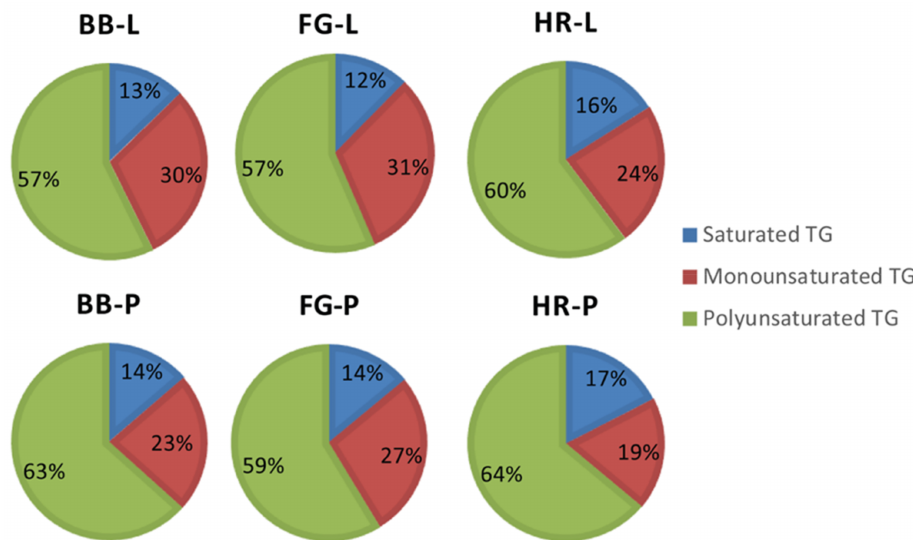
Figure 8. Compositional change in unsaponified triacylglycerols (TGs) in natural herbal soaps infused with wild berry extracts. Natural soap acronyms: BB = base bar, FG = forest grove, HR = hibiscus rosehip, L = blueberry, P = partridge